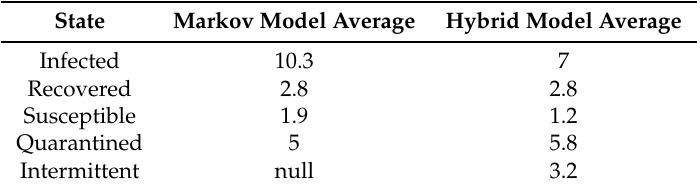
Table 5. Average results of 50 simulations of the Markov model and the hybrid